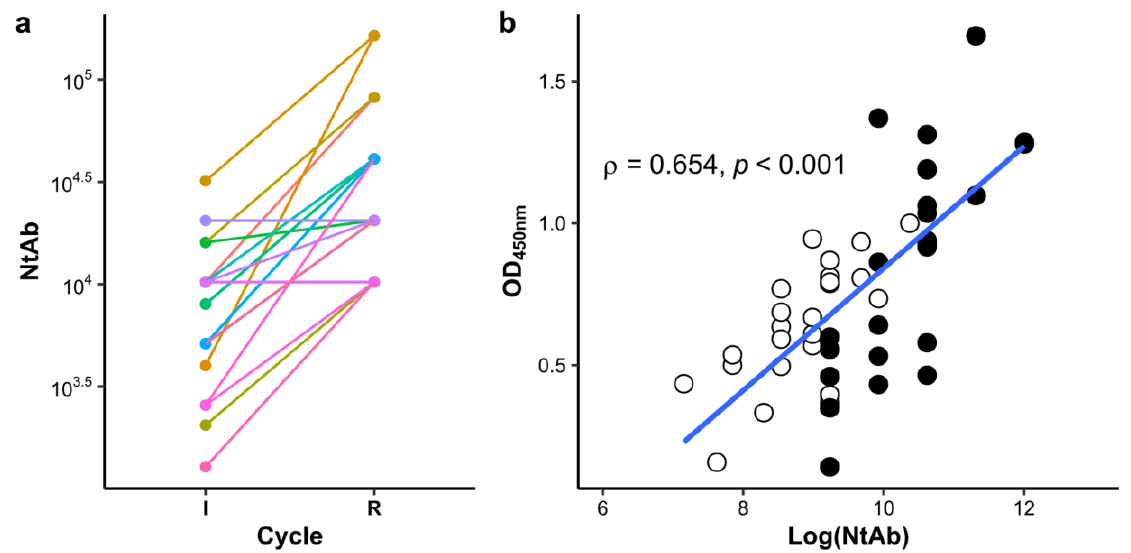
Figure 2. ( a ) NtAb contrast in HHS at final blood collection date during I and R cycles. HHS were collected from horses 7 days after receiving their last immunization dose. These HHS are the starting material for EpAbs production. Their viral infection neutralization titer (NtAb) was estimated as described in Section 2 and grouped according to their corresponding immunization cycles (as stated in x -axis). Paired dot and lines are represented for each horse to aid visual inspection and analysis of both individual and group difference. Statistical inference analysis between groups is included in the text. ( b ) Correlation analysis between indirect ELISA and viral neutralization results. Indirect ELISA results (OD 450 nm ) on HHS of horses from the I (white circles) and R (black circles) were plotted against log transformed viral neutralization antibodies titers (Log(NtAb)). Spearman’s rank correlation coefficient is depicted in the chart together with the p value associated with rejecting the null hypothesis (that OD 450 nm and Log(NtAb) are not correlated) whether it is true. A linear regression line is shown in blue to aid visual inspection of the data.